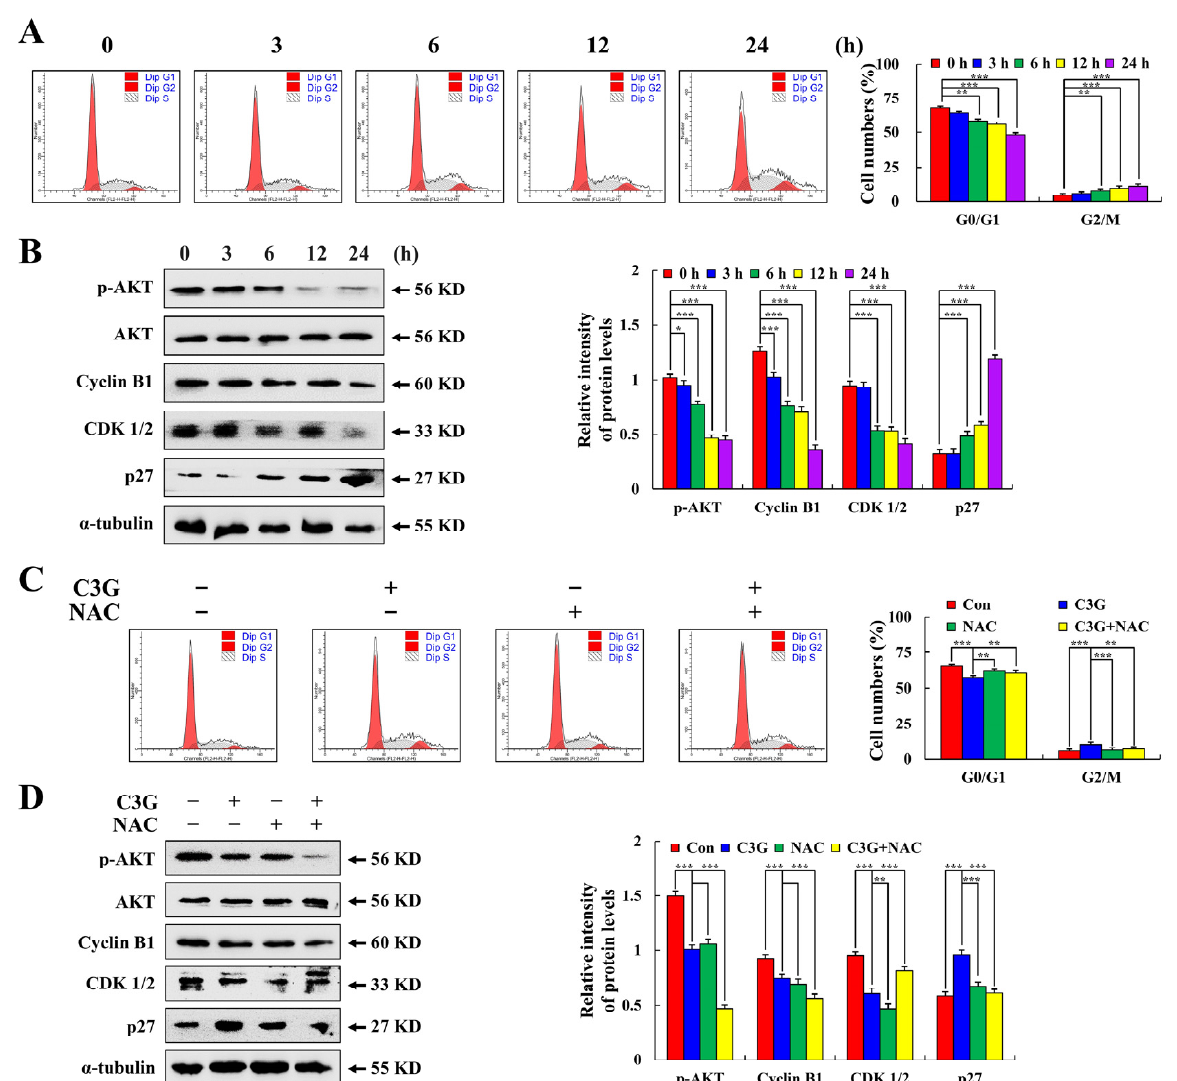
Figure 6. Cell cycle arrest effects of C3G on MKN-45 cells. ( A ) Percentage of cell cycle detected by flow cytometry. ( B ) G2/M cyclin-related protein expression levels after C3G treatment, cyclin AKT, cyclin B1, CDK 1/2, and p27 were detected using Western blot. ( C ) Percentage of MKN-45 cells treated with NAC and C3G was determined using flow cytometry. ( D ) MKN-45 cells were treated with C3G and NAC, and cyclin B1, CDK 1/2, and p27 were detected using Western blot. α -tubulin served as an internal reference (* p ≤ 0.05, ** p ≤ 0.01, *** p ≤ 0.001 vs. 0 h or the NAC + C3G group).